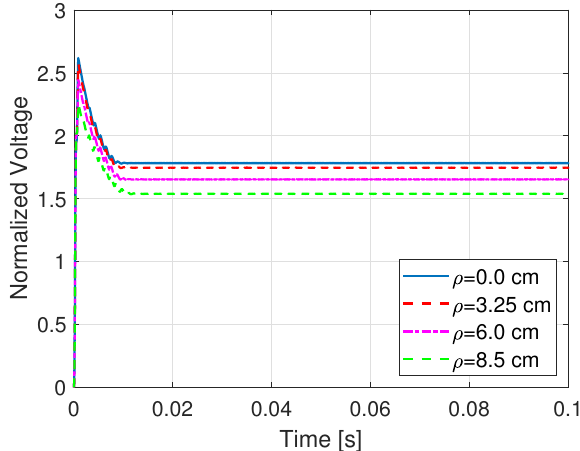
Figure 8. Load normalized voltages with h = 20